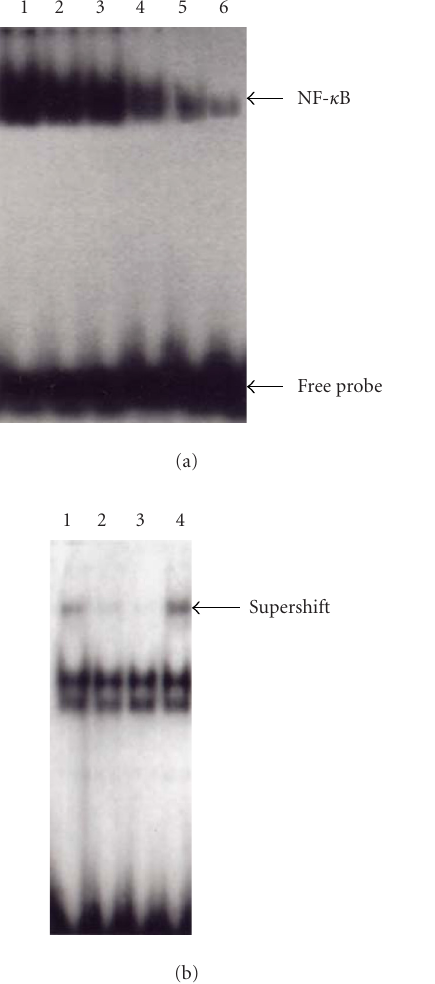
Figure 5. Electrophoretic mobility shift assay demonstrating nuclear translocation and DNA binding of NF- κ B. (a) Lanes 1– 6: model, melatonin(2.5, 5.0, 10.0 mg.kg − 1 ), 5-ASA, normal. (b) Lanes 1–4: the model group, lanes 2–3: specific competitor (us- ing excess of unlabeled oligonucleotide), lanes 1 and 4: super- shift (addition of p65 antibodies to the nuclear extracts).